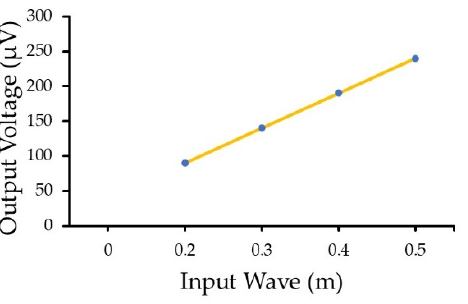
Figure 11. Linear relationship between the output voltage and the input ocean waves.